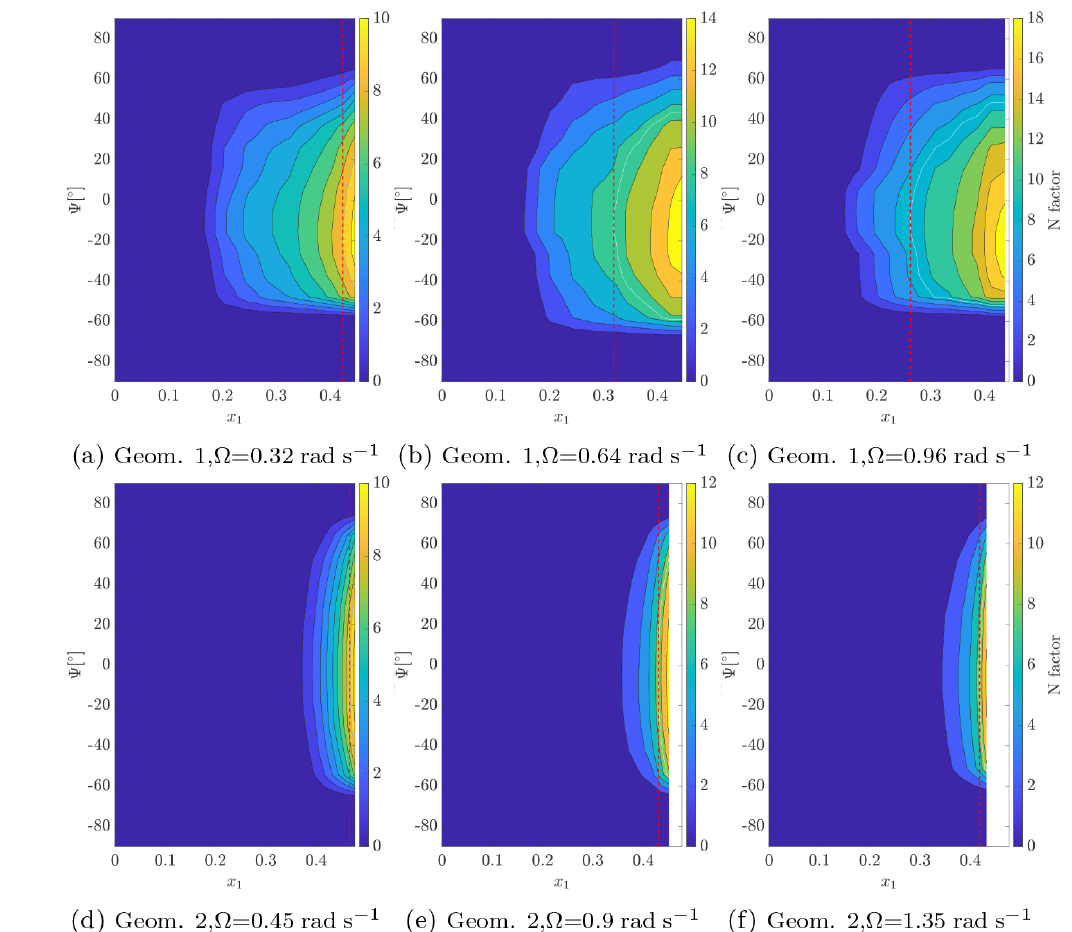
Figure 15. N -factor contours from PSEX at r 0 /R = 0 . 58 for several rotation speeds. The white line indicates the critical region, and the red dashed line shows the transition